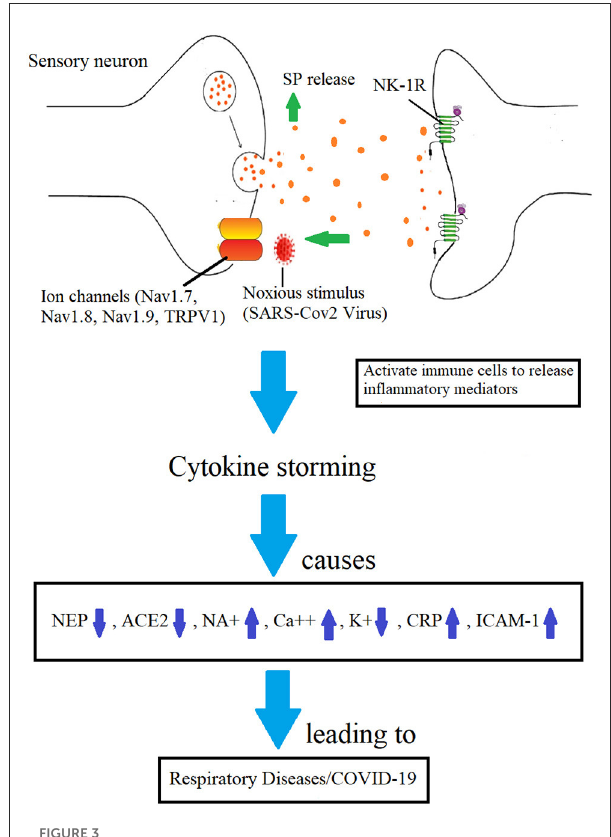
FIGURE3 Mechanisms involved in the development of COVID-19 infection by which SP-induced inflammation is implicated. Increased BBB permeability and immune cell cytokine release are caused by SP’s binding to the NK-1R on endothelial cells